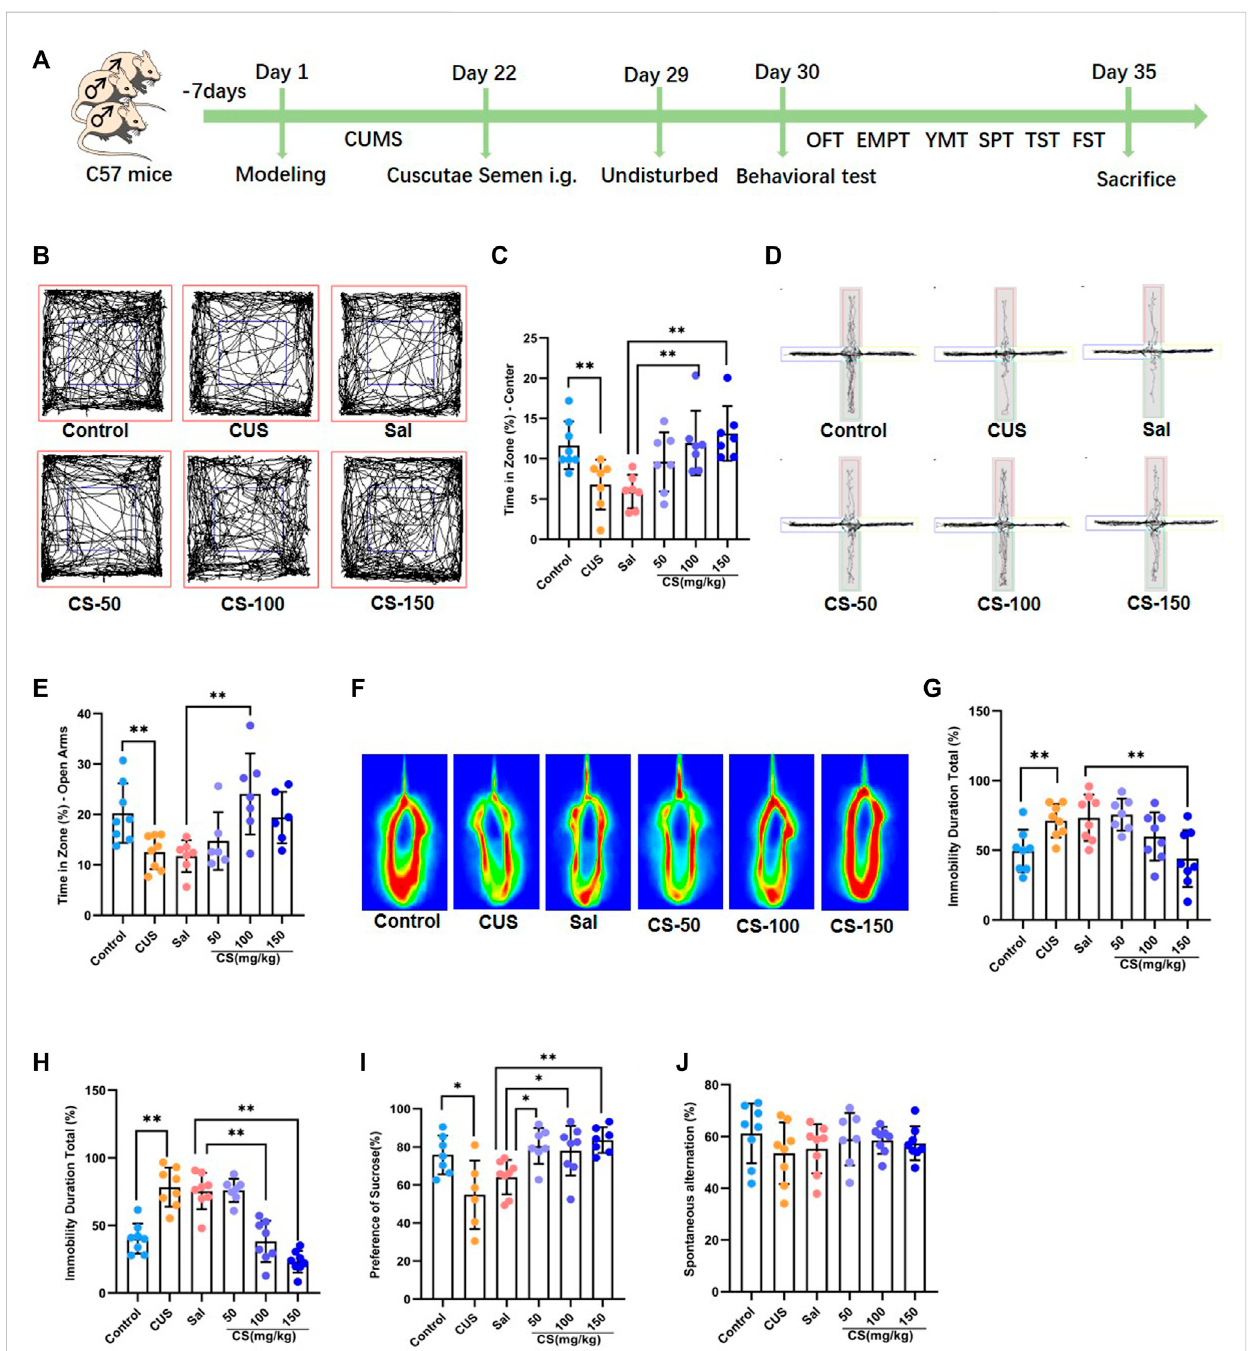
FIGURE 1 CSrelieveddepression-likebehaviorsinmiceexposedtoCUS. (A) Experimentalprocedure. (B,C) Themotiontrailandtimespentinthecenterzone intheOFT. (D,E) ThemotiontrailandtimespentintheopenarmsintheEPMT. (F,G) ThepercentageofimmobilitytimeintheTST. (H) Thepercentageof immobility time in the FST. (I) The percentage of sucrose in the SPT. (J) Spontaneous alternation in the FST. Data are expressed as the mean ± standard error. * p < 0.05, ** p <